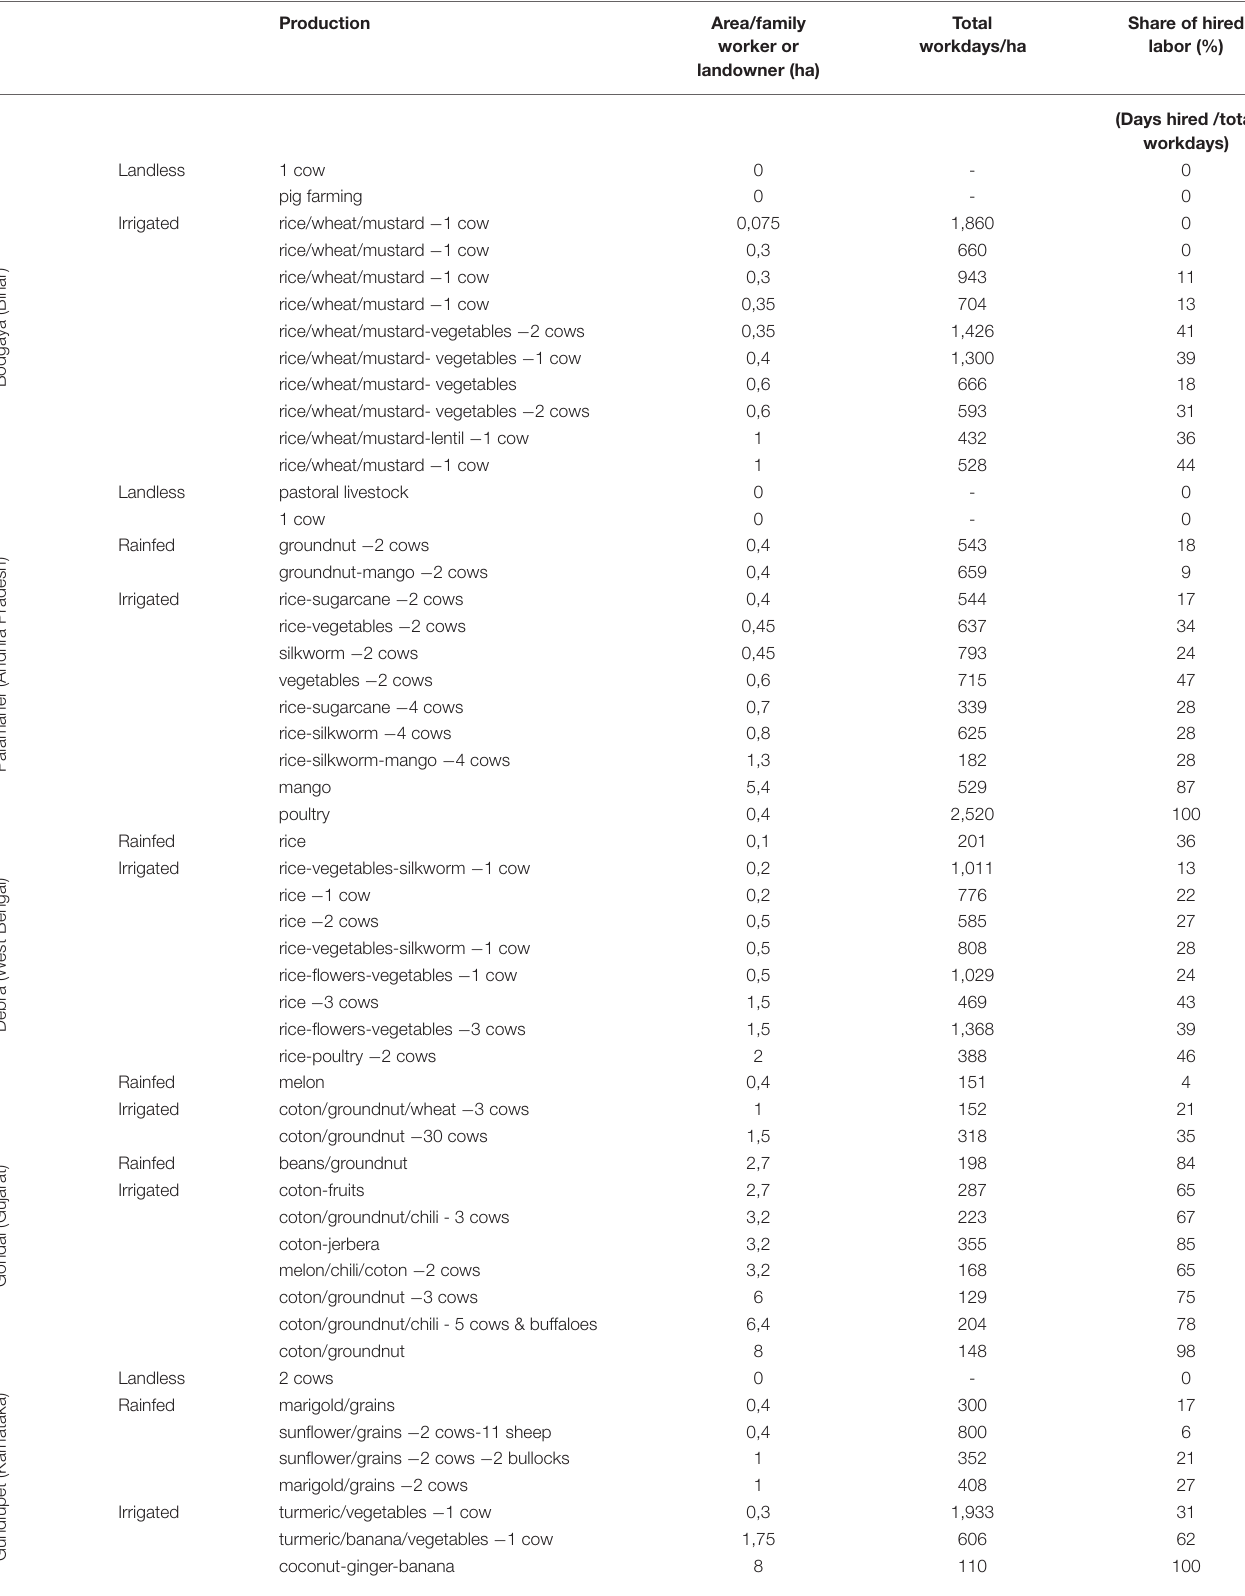
TABLE 2 | Use of paid work in the production systems in five study regions.